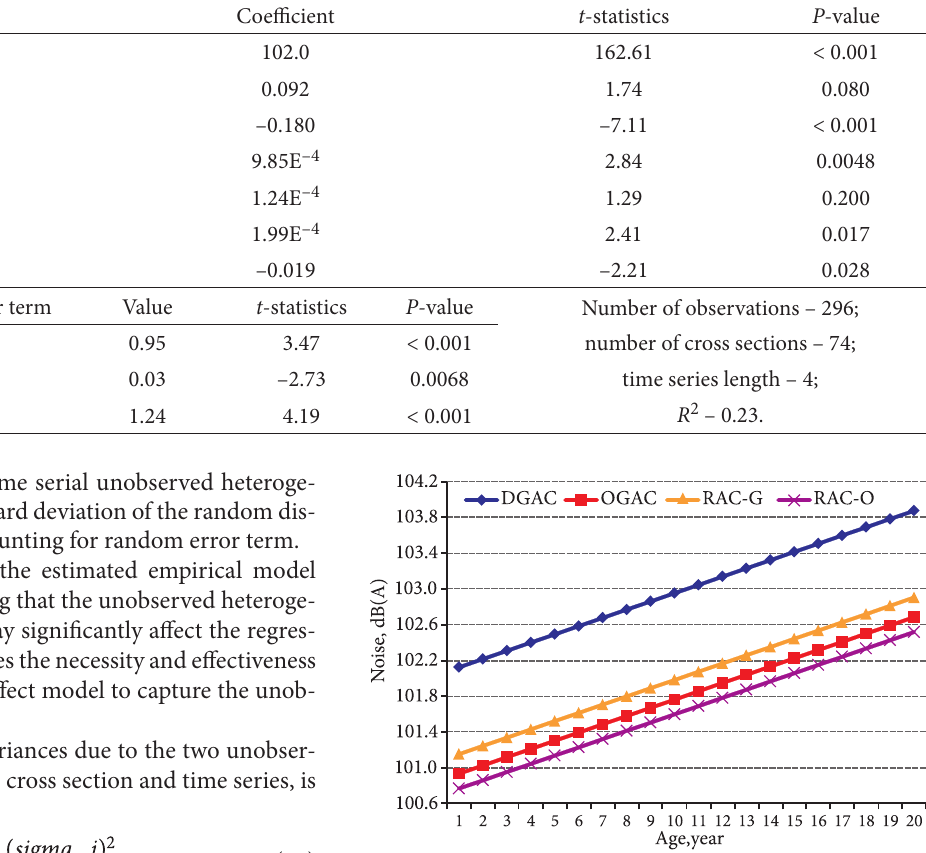
Fig. 1. Noise level development of each